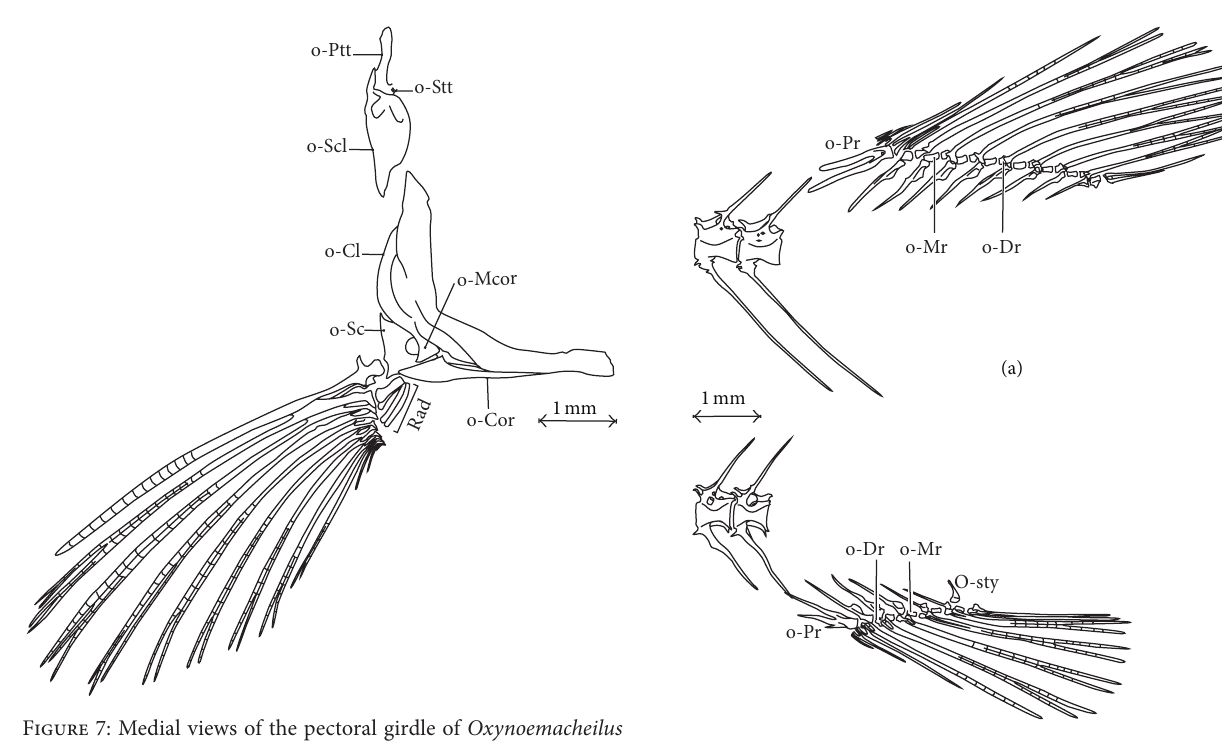
Figure 7: Medial views of the pectoral girdle of Oxynoemacheilus chomanicus . Cl: cleithrum; Cor: coracoid; Mcor: mesocoracoid; Ptt: posttemporal; Rad: ossified pectoral radial; Sc: scapula; Scl: supracleithrum; Stt: supratemporal. Figure 8: (a) Dorsal fin and (b) anal fin of Oxynoemacheilus